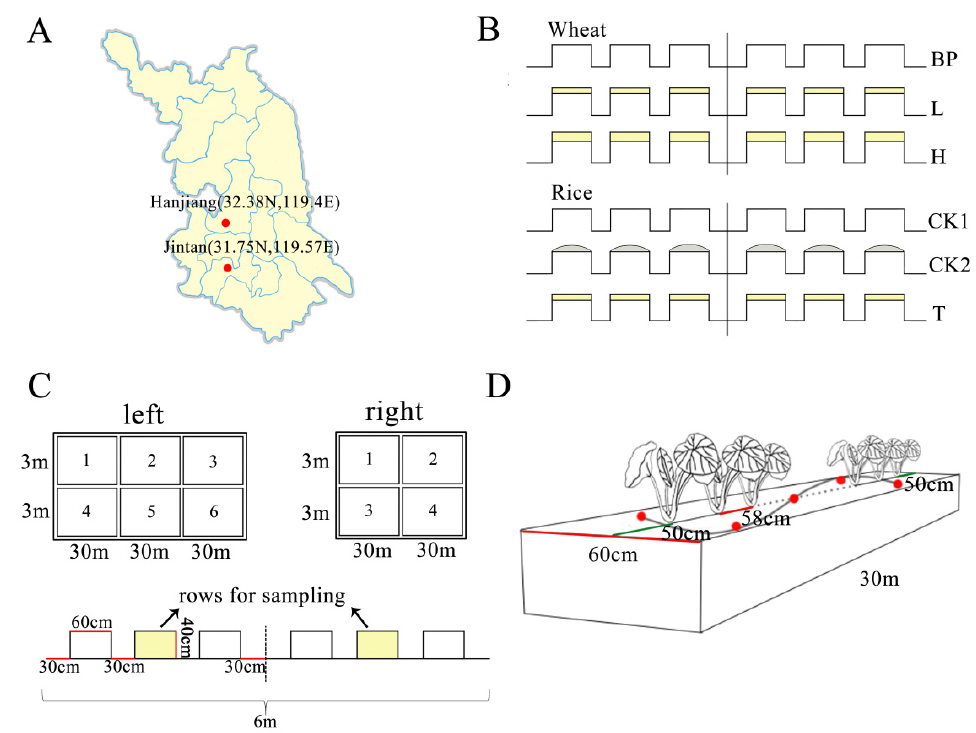
Figure 1. Experimental design. ( A ) Orientation of two test points in Jiangsu Province, China. ( B ) Treat- ments. Yellow indicates laying of straw, and gray indicates laying of film mulching. ( C ) Planting diagram of two experiments (only one block is shown for each experiment). In the wheat straw mulching experiment, plastic tunnels of 90 m × 6 m were used. Five treatments (including control) were randomly arranged in one plastic tunnel as one repetition ( left ). In the rice straw mulching experiment, plastic tunnels of 60 m × 6 m were used. Three treatments (including control) were randomly arranged ( right ). ( D ) Taro planting and soil sampling. BP: before planting; L: straw mulching 11,250 kg/ha; H: straw mulching 18,750 kg/ha; CK1: taro seedlings were directly planted in the rows without mulching; CK2: seedlings were covered with black mulching film; T: rice straw mulching at 15,000